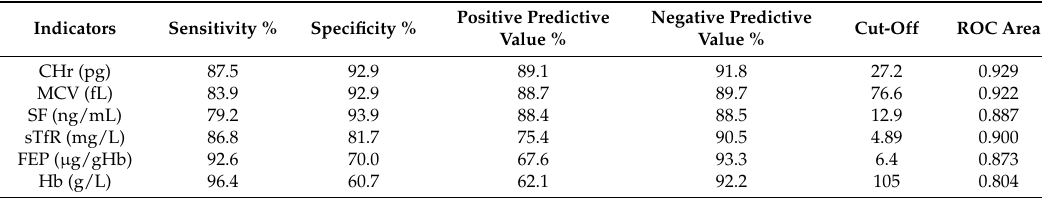
Table 4. Optimal prognostic values of different blood parameters for iron deficiency anemia according to receiver operating characteristic curve.